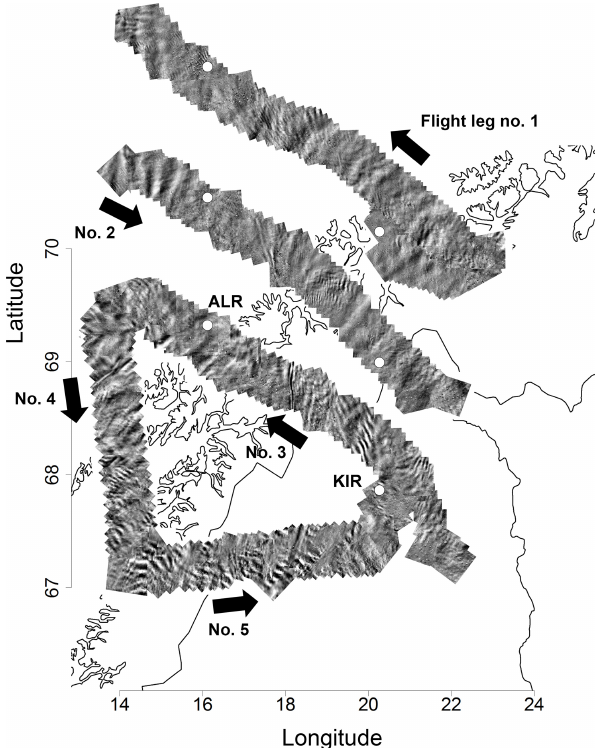
Figure 7. Difference images of the first flight (14 January). A differ- ence image is derived by subtracting the intensity measured by each pixel from the intensity measured 10s later by the same pixel. The velocity of the airplane is approximately 210ms − 1 . So, the airplane moves ca. 2km in 10s. Calculating a difference image emphasizes horizontal structures which change significantly within 2km and/or within 10s in flight direction. Please note that the first three legs cover the same area, but legs one and two have been shifted for a better display. The black arrows show the flight direction. Appar- ently, the small-scale structures change rapidly within a few min-